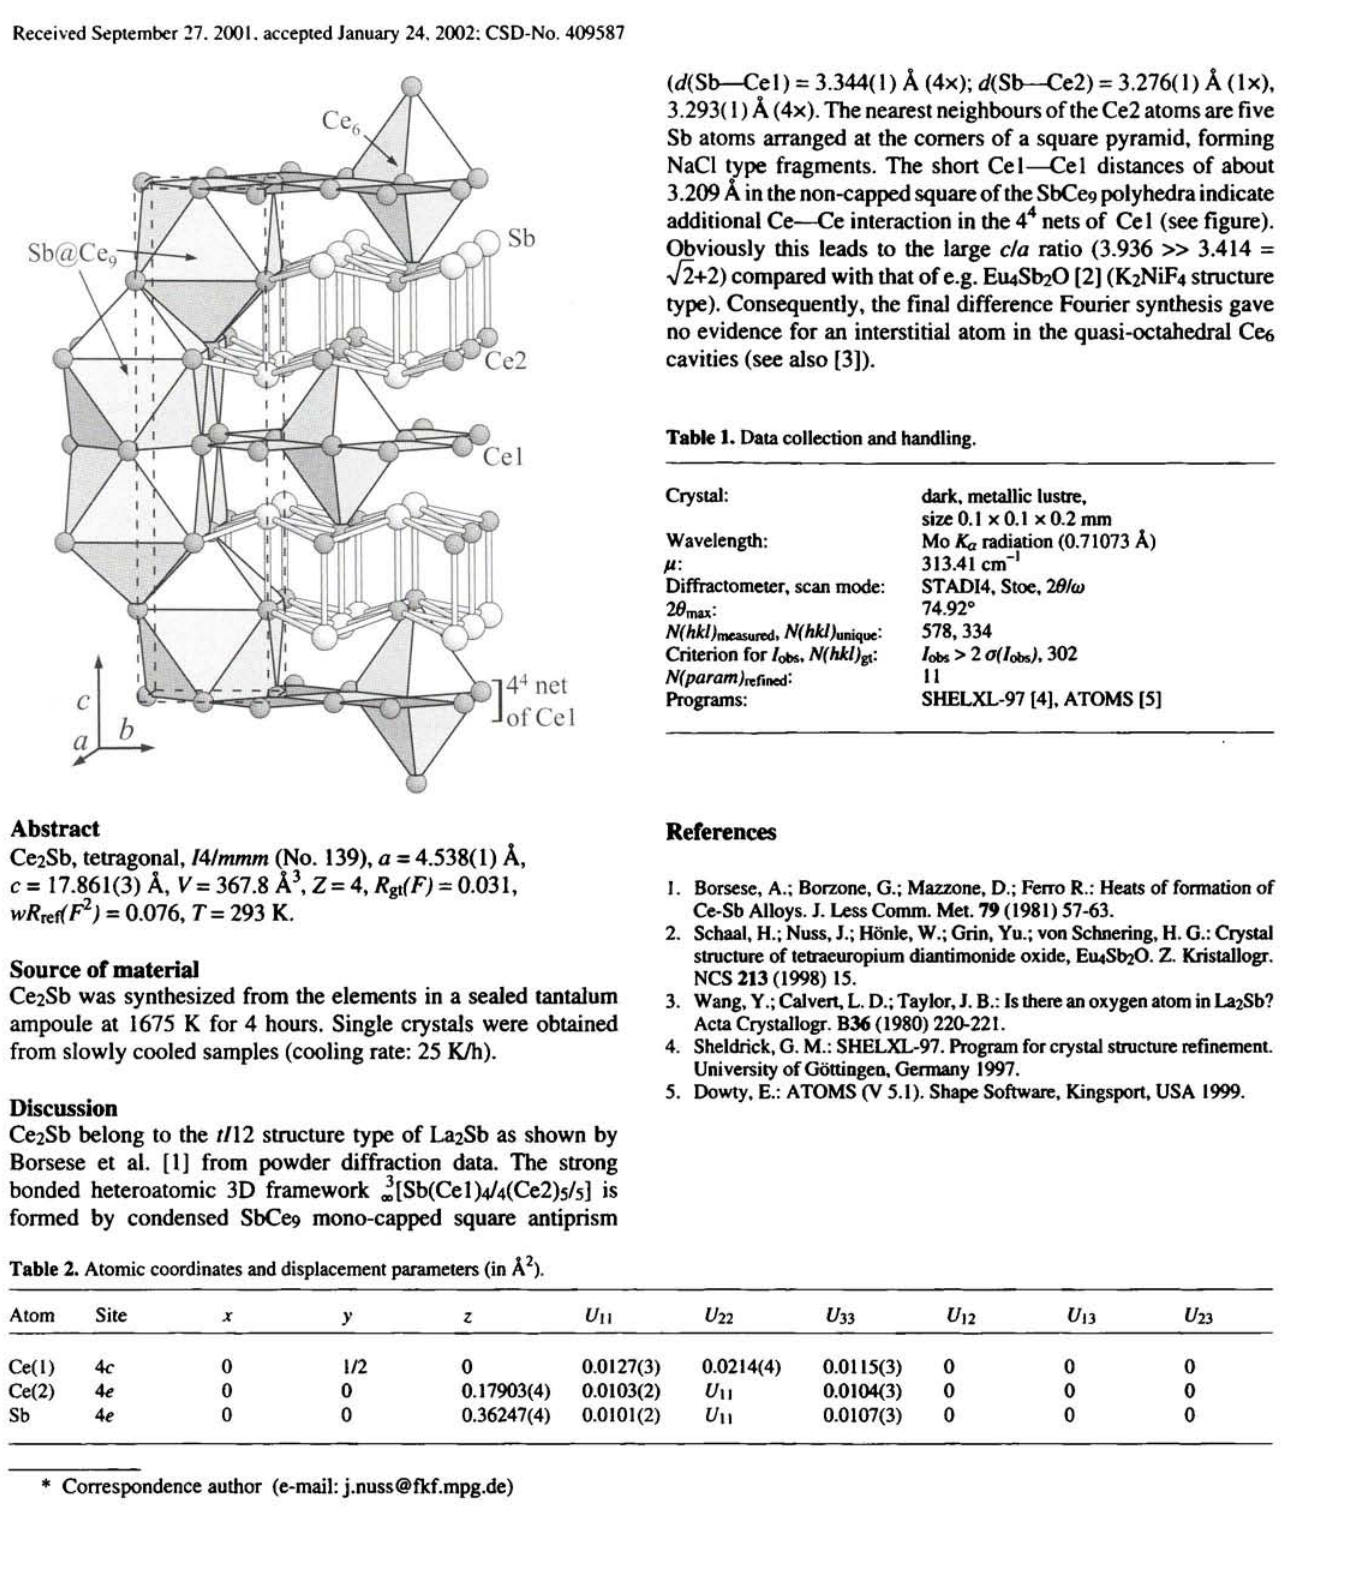
Table 2. Atomic coordinates and displacement parameters (in Â 2 ).